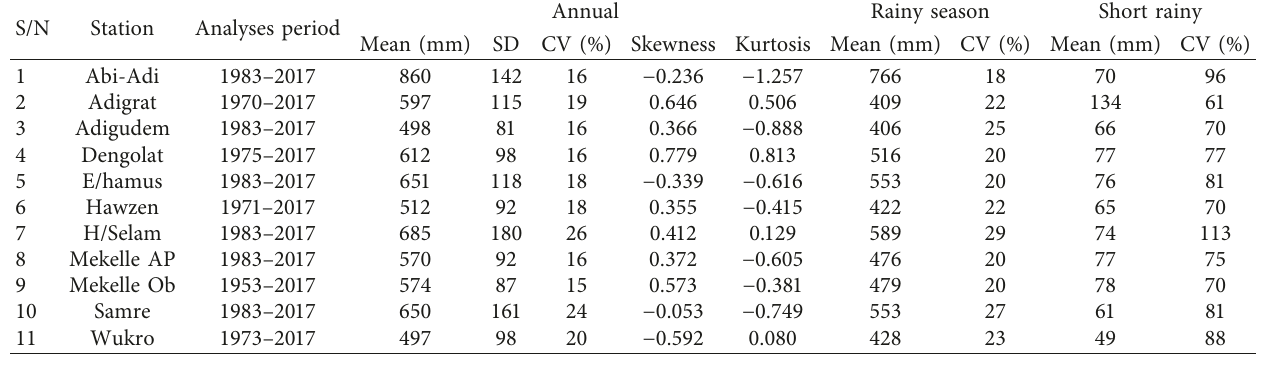
Table 2: Summary of descriptive statistical analysis of rainfall stations.